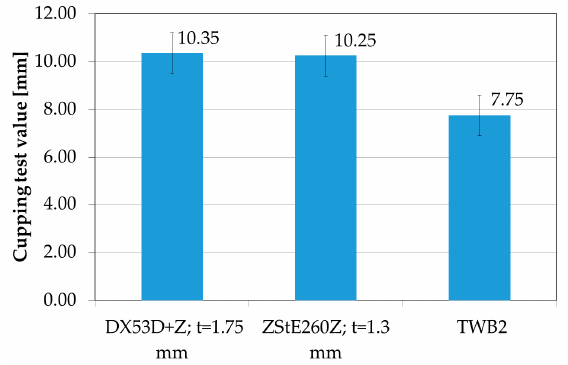
Figure 15. The Erichsen cupping test value of the base materials and TWB2.